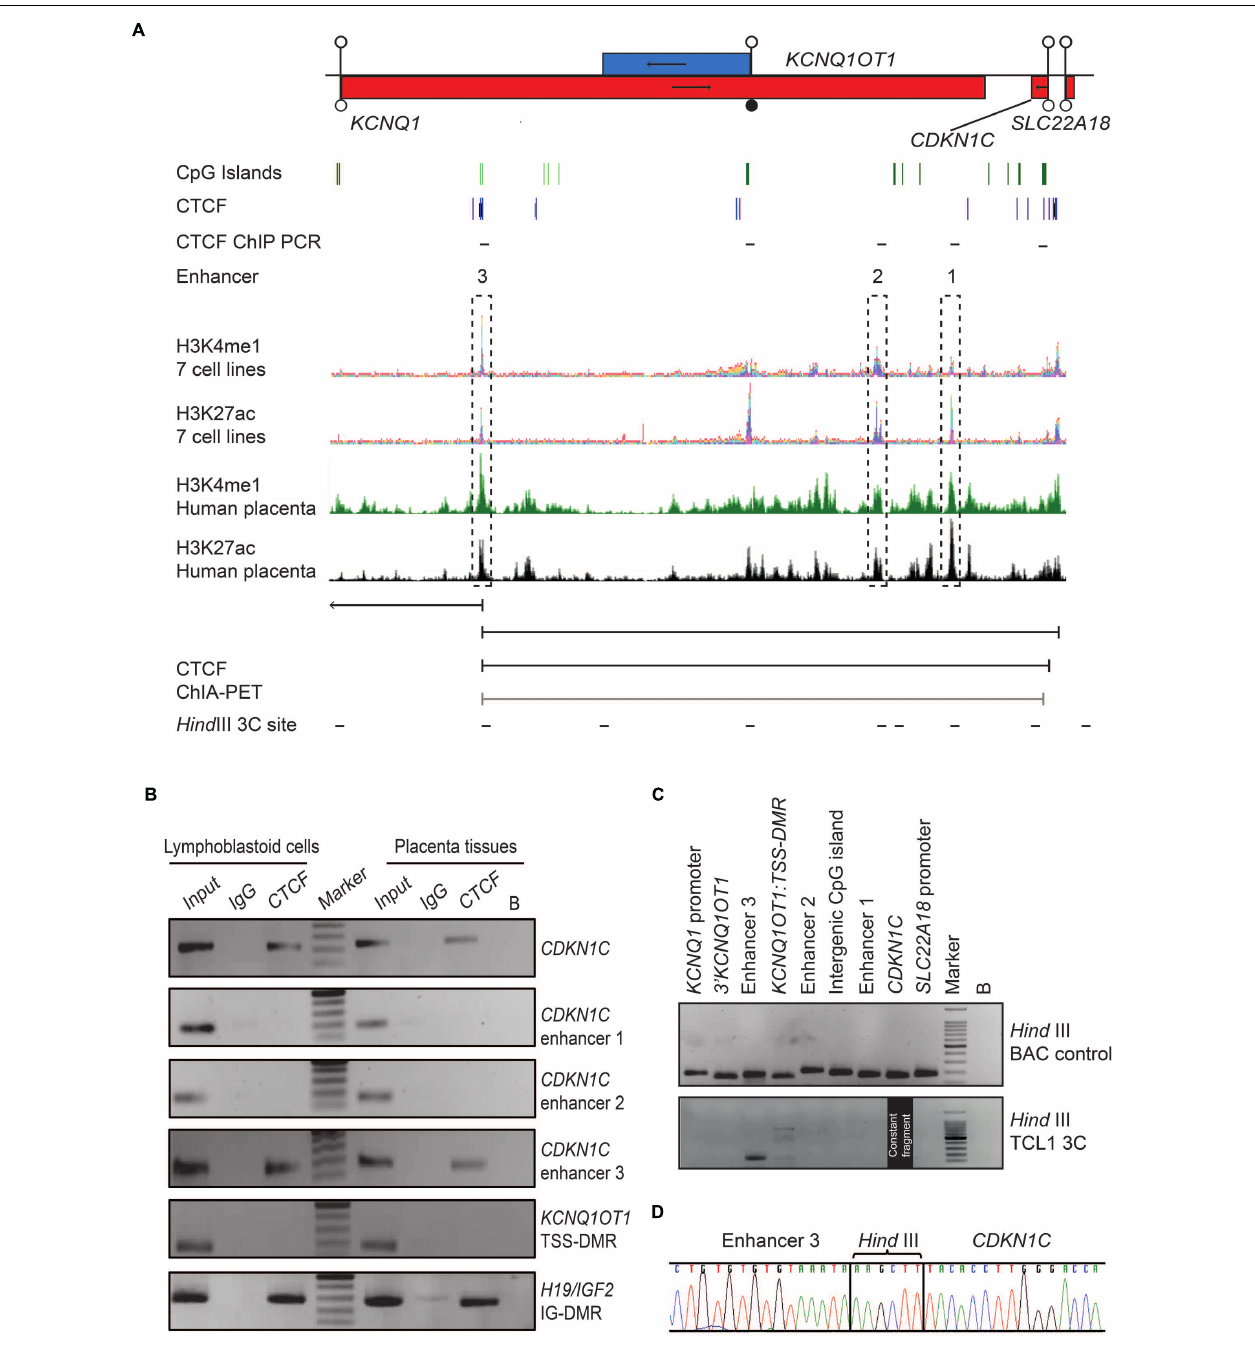
FIGURE 5 | Chromatin conformation capture (3C) interaction across the 440 kb KCNQ1-CDKN1C region in human placenta. (A) Map of KCNQ1OT1 - CDKN1C domain showing location of three putative enhancer regions in multiple cell types defined by overlapping H3K4me1 and H3K27ac ChIP-seq peaks and the relative position of transcripts, promoter and DMRs. The same intervals also show the canonical histone enhancer signature in first trimester placenta ChIP-seq datasets. ChIA-PET color coding represents signal enrichment based on aligned reads; Black for high frequency interactions, gray for medium intensity interactions. The positions of CTCF sites and HindIII sites utilized for 3C analysis are shown. (B) CTCF ChIP performed in placenta and lymphoblastoid cells. Input chromatin was used as a positive control (input 5%). ChIP-recovered DNA, analyzed using PCR and the resulting amplicons visualized using agarose gel electrophoresis. (C) All 3C PCR products were sized and visualized on a 2% agarose gels. The upper panel depicts the 3C PCR control in HindIII digested and ligated BAC control DNA. Each target primer combination was analyzed with the reverse primer of the constant region mapping to a HindIII site within the CDKN1C gene. The lower panel shows the 3C analysis performed on DNA-derived from cross-linked, digested and ligated chromatin from the placenta cell line TCL1. 3C PCR products of correct size were observed for the enhancer 3 interaction. (D) Sequence analysis reveals the appropriate ligation products following 3C PCR depicting higher-order chromatin contact between the CDKN1C constant fragment and the enhancer 3 region.